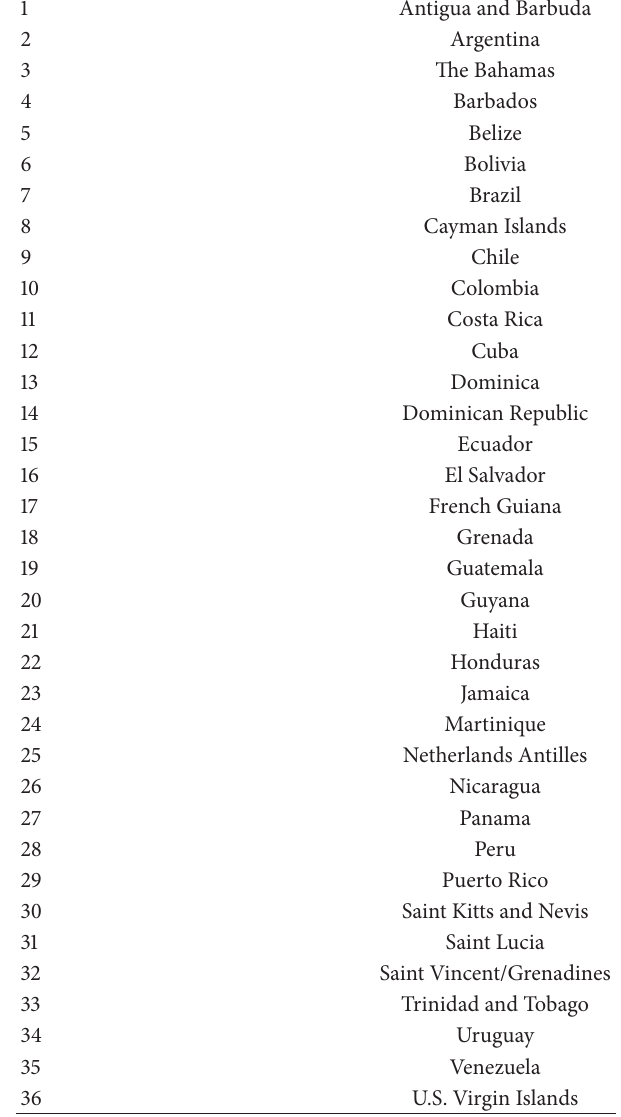
Table 4: Countries considered in the Central and South American